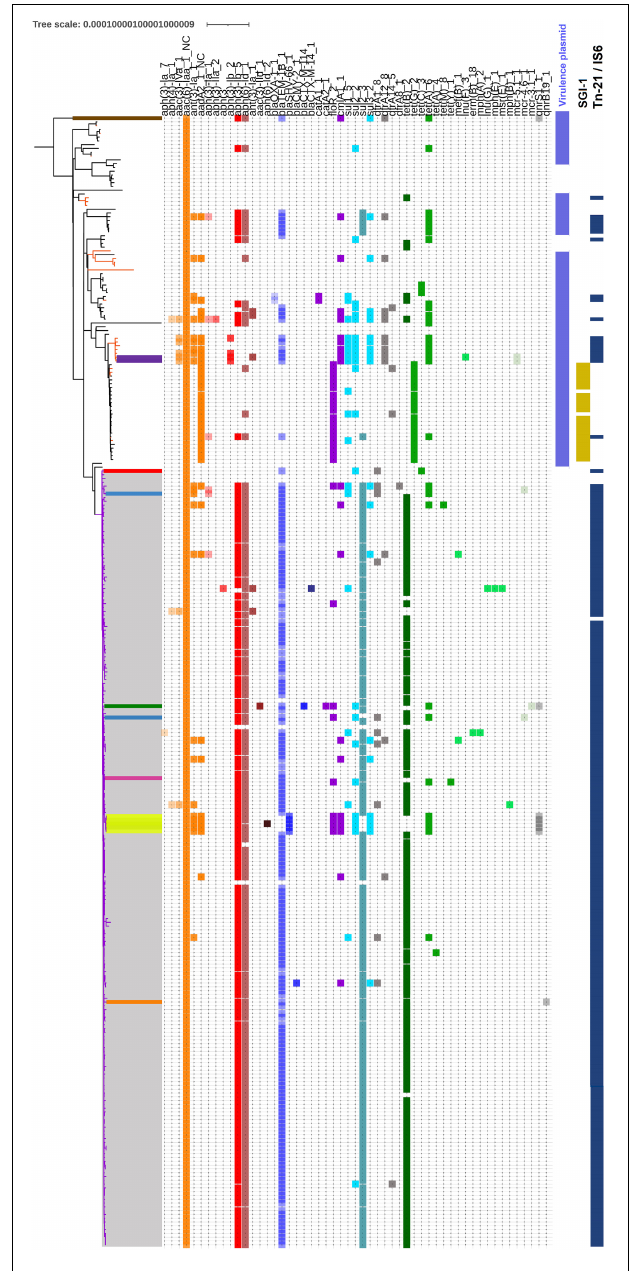
FIGURE 5 | Distribution and diversity of acquired resistance genes. All the strains carrying plasmids are underlined with a colored range. The strains 2002LSAL10320 and 2004LSAL04350 harboring the mcr -5.1 gene mediating colistin resistance in a plasmid highly similar (99.95% of identity) to the E. coli plasmid pEC0674 (MF684783.1) are highlighted in purple. The strain ERR2849932 carrying the qnr S1 gene in a 28 Kb sequence similar to a fragment of the pK91-like plasmids is highlighted in brown. The strains ERR2174790 and ERR2003341 carrying the mcr -4.6 gene mediating for colistin resistance in a large contig (476 Kb) is highlighted in light blue. The strain ERR2187916 carrying the mcr -3.1 gene in a small contig identical to a fragment of the plasmid p08-5333.1 is highlighted in green. The strains ERR1744967-71 likely carrying 2 plasmids, the plncX-SHV encoding the qnr S1_1 gene and a E. coli -like plasmids never described before encoding the